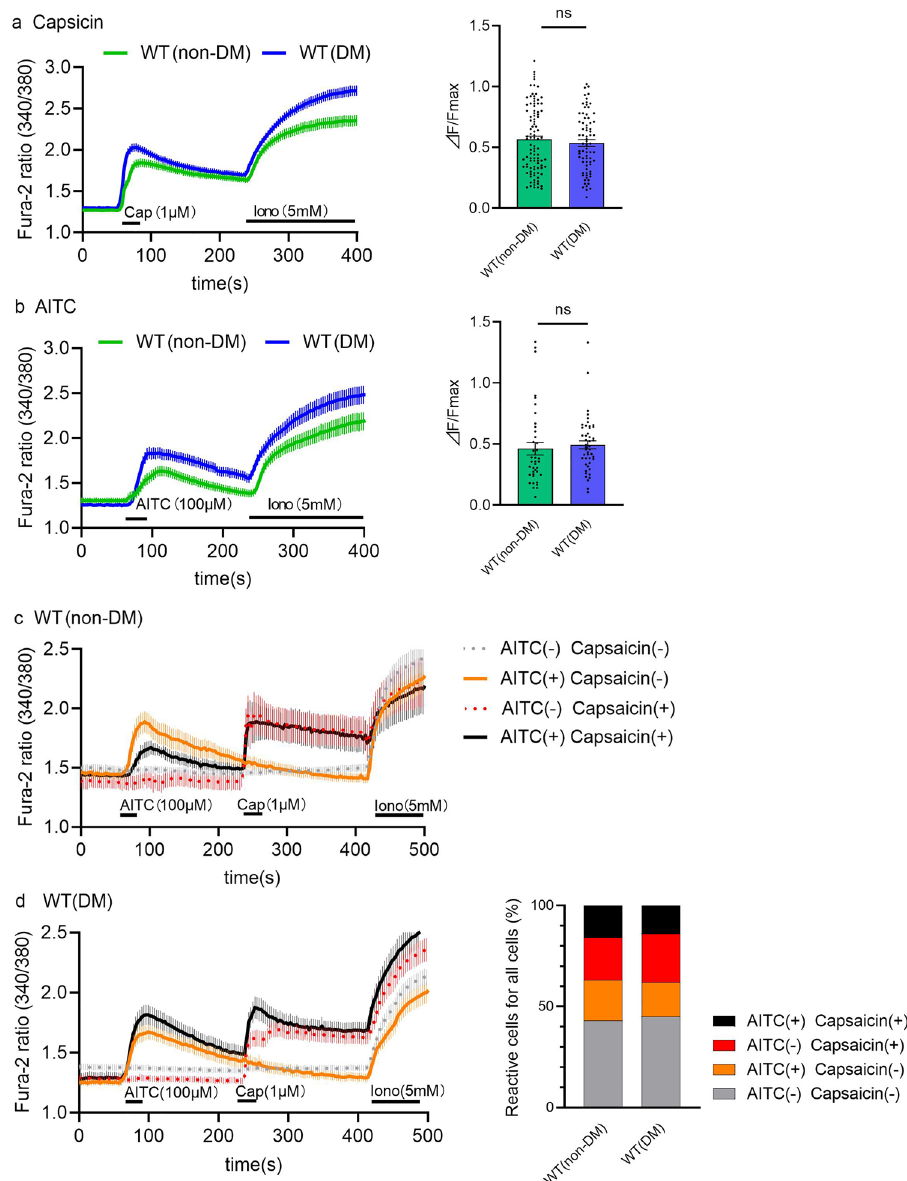
Figure 4. Functions of TRPV1 and TRPA1 in the dorsal root ganglia of mice 5 weeks after STZ administration. ( a,b ) (Left) Traces of mean Fura-2 ratios corresponding to intracellular Ca 2+ concentrations in DRG neurons upon application of capsaicin (Cap) (1 μM, ( a ) in WT (non-DM) (green, n = 100 cells from 6 mice) or WT (DM) (blue, n = 74 cells from 5 mice), or allyl isothiocyanate (AITC) (100 μM, ( b ) in WT (non-DM) (green, n = 39 cells from 5mice) or WT (DM) (blue, n = 47 cells from 5mice) mice. (Right) Comparison of the values of the capsaicin-evoked Ca 2+ responses (ΔF)/ionomycin-evoked Ca 2+ responses (F max ) (normalized ratios). ( c,d ) Traces of mean Fura-2 ratios in DRG neurons from WT (non-DM) ( c , n = 104 cells from 5mice) and WT (DM) ( d , n = 177 cells from 5mice) mice in response to application of capsaicin (1 μM) or AITC (100 μM). There are 4 kinds of neurons: no responses to both chemicals (AITC (−) Capsaicin (−), gray dotted line), responses to AITC alone (AITC (+) Capsaicin (-), orange solid line), responses to capsaicin alone (AITC (−) Capsaicin (+), red dashed line), and responses to both AITC and capsaicin (AITC (+) Capsaicin (+), black solid line). ( e ) Distribution of the 4 kinds of cells is shown in ( c and d ). The data are presented as the means ± SEM. A two- tailed t test was used for comparison. ns = not significant. Dots indicate each